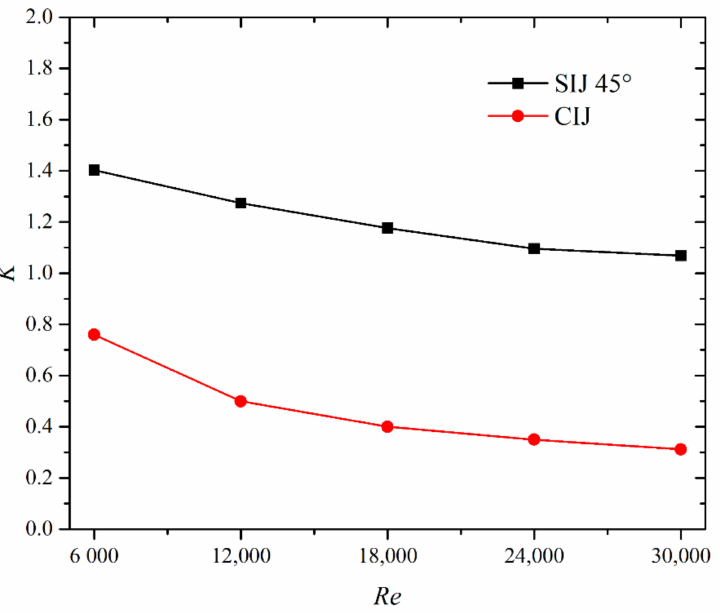
Figure 16. Variation of pressure loss coefficient (K) of SIJ 45 ◦ and CIJ at various